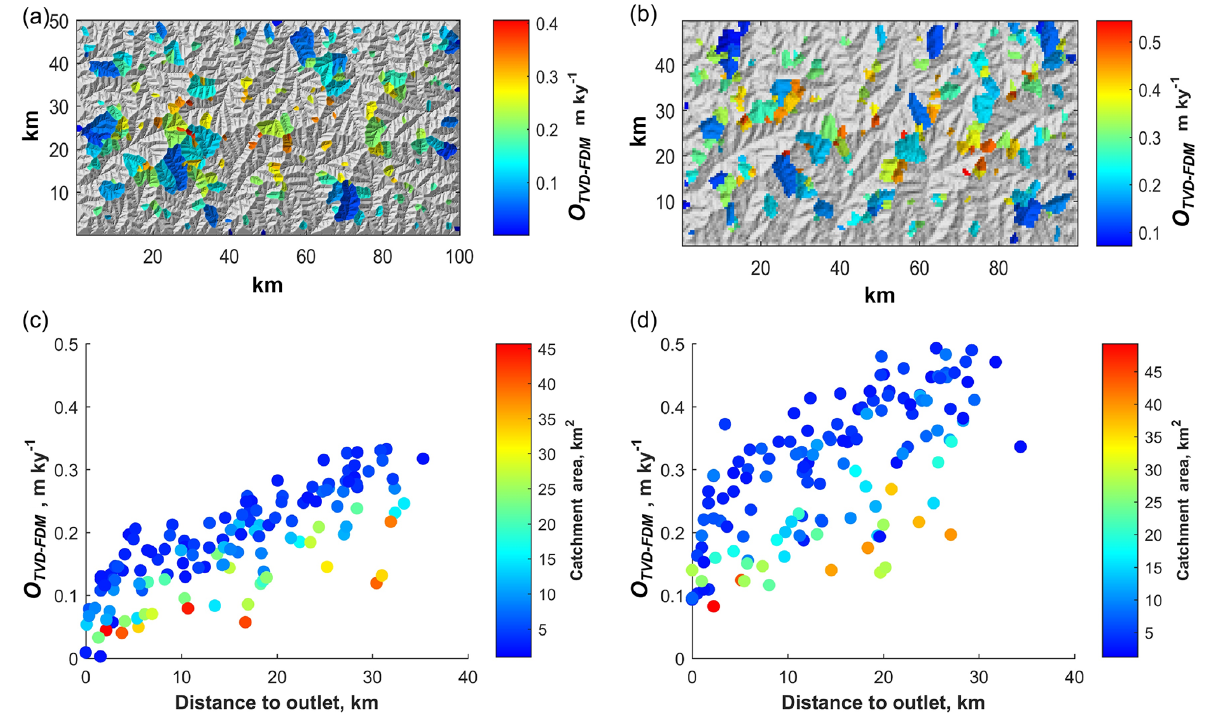
Figure 7. Spatial variation of differences between simulated erosion rates calculated with a flux-limiting TVD-FVM for simulating river incision and a first-order accurate implicit FDM. Here, we compare methods that are both run with an inner time step constrained with the CFL criterion (see text). O TVD − FDM is thus calculated between the black and red lines from Fig. 6. The left column represents simulations run at a spatial resolution of 100m, the right column at 500m. (a, b) Location of the randomly selected catchments with an area >1 and <50km 2 . Colors refer to the O TVD − FDM between the two simulations. (c, d) Differences between the schemes increase with increasing distance from the river outlets and are inversely correlated with the catchment